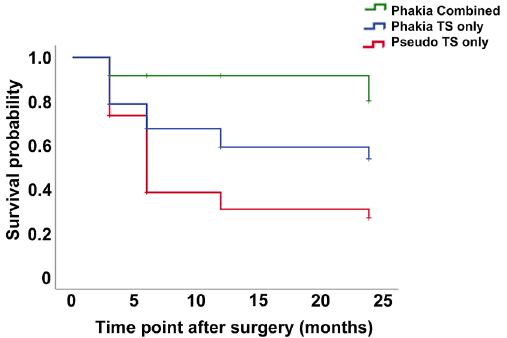
Figure 2. Kaplan–Meier survival analysis according to the preoperative lens status and surgical procedures, with survival defined as intraocular pressure (IOP) < 15 mmHg and ≥ 20% compared reduction with baseline and with no additional treatments. Data on phakic eyes that underwent Trabectome surgery (TS) and combined cataract surgery (green), phakic eyes that underwent TS only (blue), and pseudophakic eyes that underwent TS only (red) are shown.